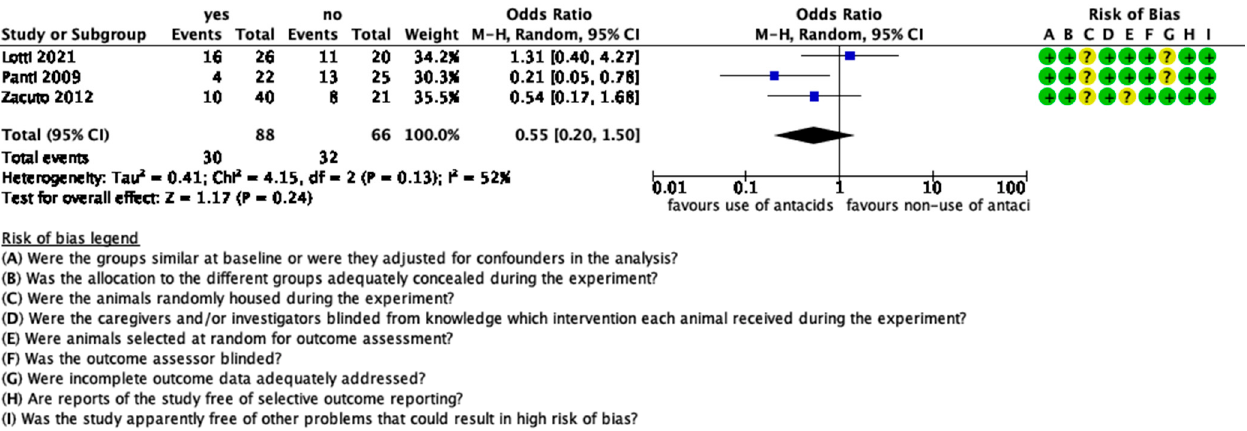
Figure 5. Forest plot of the effect of antacids on GOR. CI: confidence interval. ?: unclear risk; +: low risk.